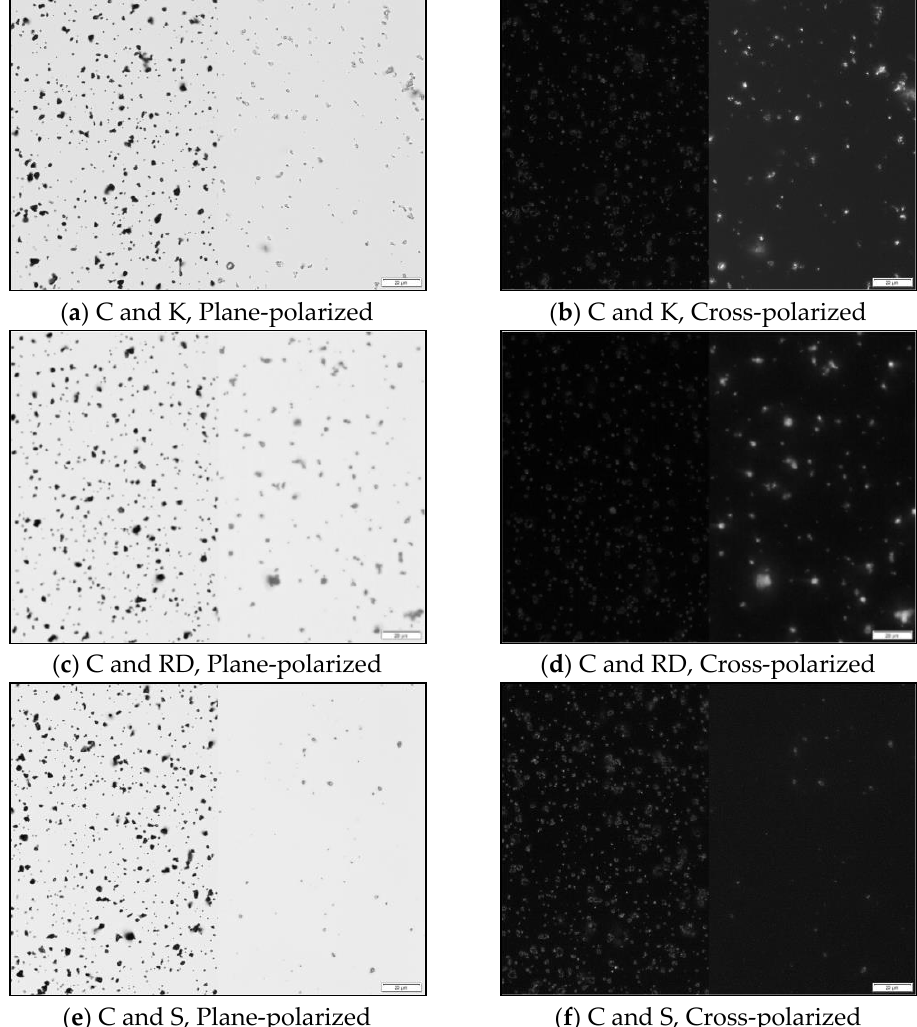
Figure 4. Examples of dual images collected under ( a , c , e ) TPP lighting conditions and ( b , d , f ) TCP lighting conditions. The left-hand side of each image contains only coal dust particles and the right-hand side contains only mineral particles. Sample types are abbreviated as C: Coal; K: Kaolinite; RD: Rock dust; and S: Silica.